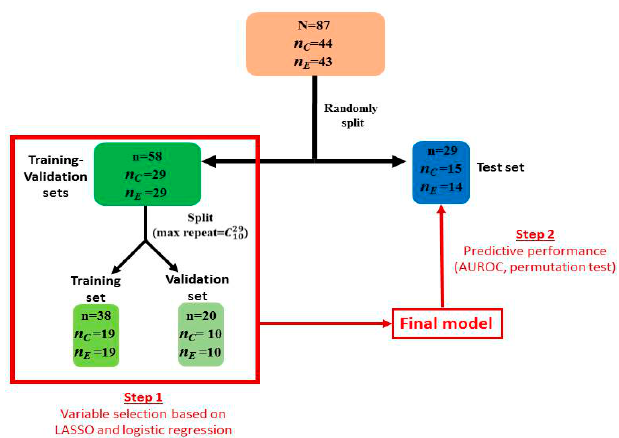
Figure 1. Multivariate analysis was conducted using training-validation (~ 2/3 of all data) and test